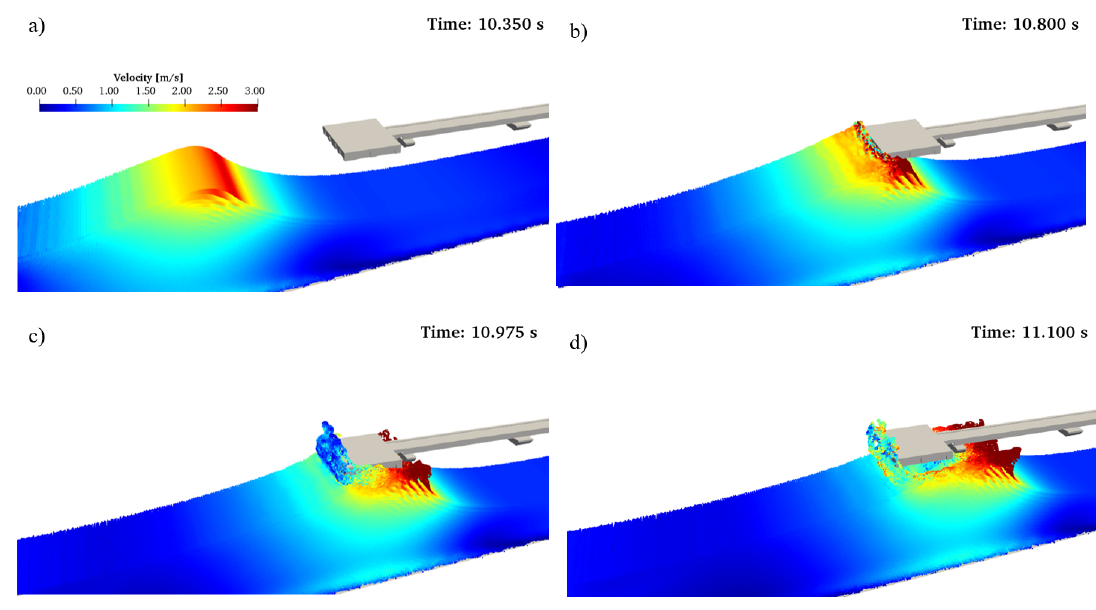
Figure 7. Snapshots of the SPH horizontal velocity contours for the test case A1. ( a ) Time: 10.350 s; ( b ) Time: 10.800 s; ( c ) Time: 10.975 s; ( d ) Time: 11.100